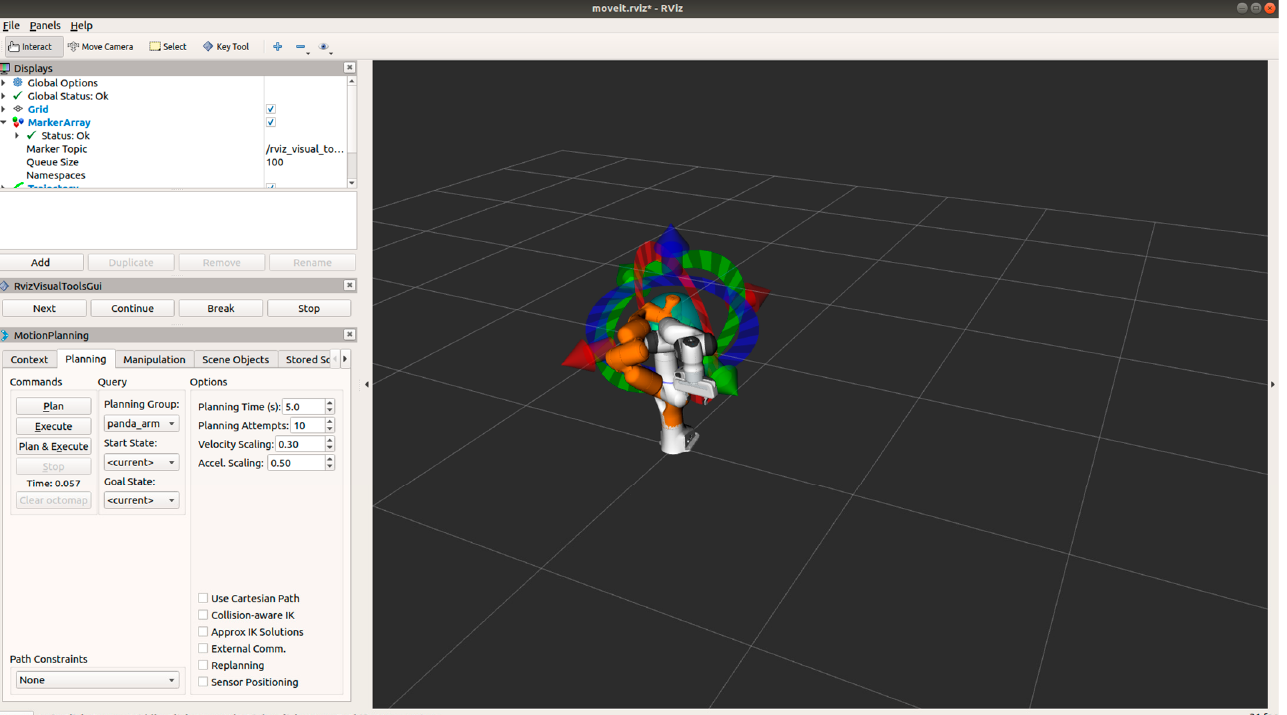
Figure 5. Screenshot of current joint states displayed in RVIZ control panel. Figure 6 shows experimental results using proposed architecture. It is noticed again that only the first axis of the robot is connected to a real servo drive. The blue line “MoveitPosition” is MoveIt planned path obtained via topic protocol. The command position (ArmCommand), feedback position (Arm Position), and motor encoder (ArmEncoder) are sampled from motion kernel in ARM development board. Every time